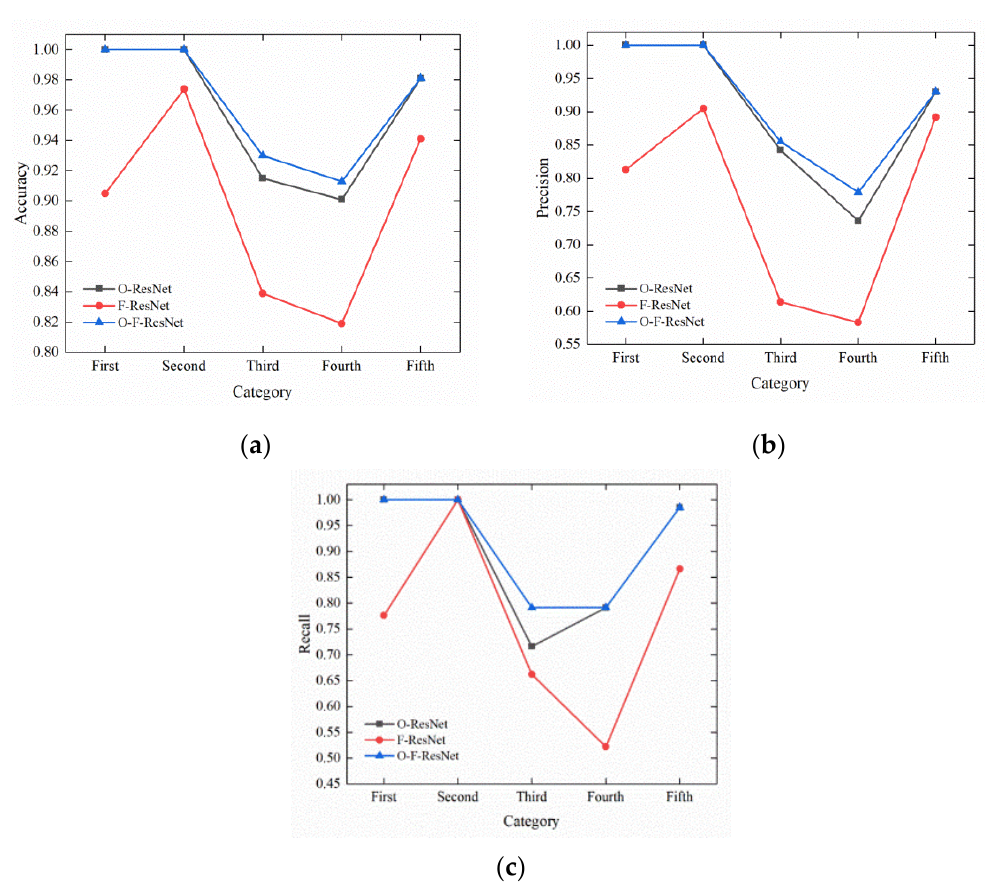
Figure 8. The accuracy ( a ), precision ( b ), and recall ( c ) of classification prediction with different models.